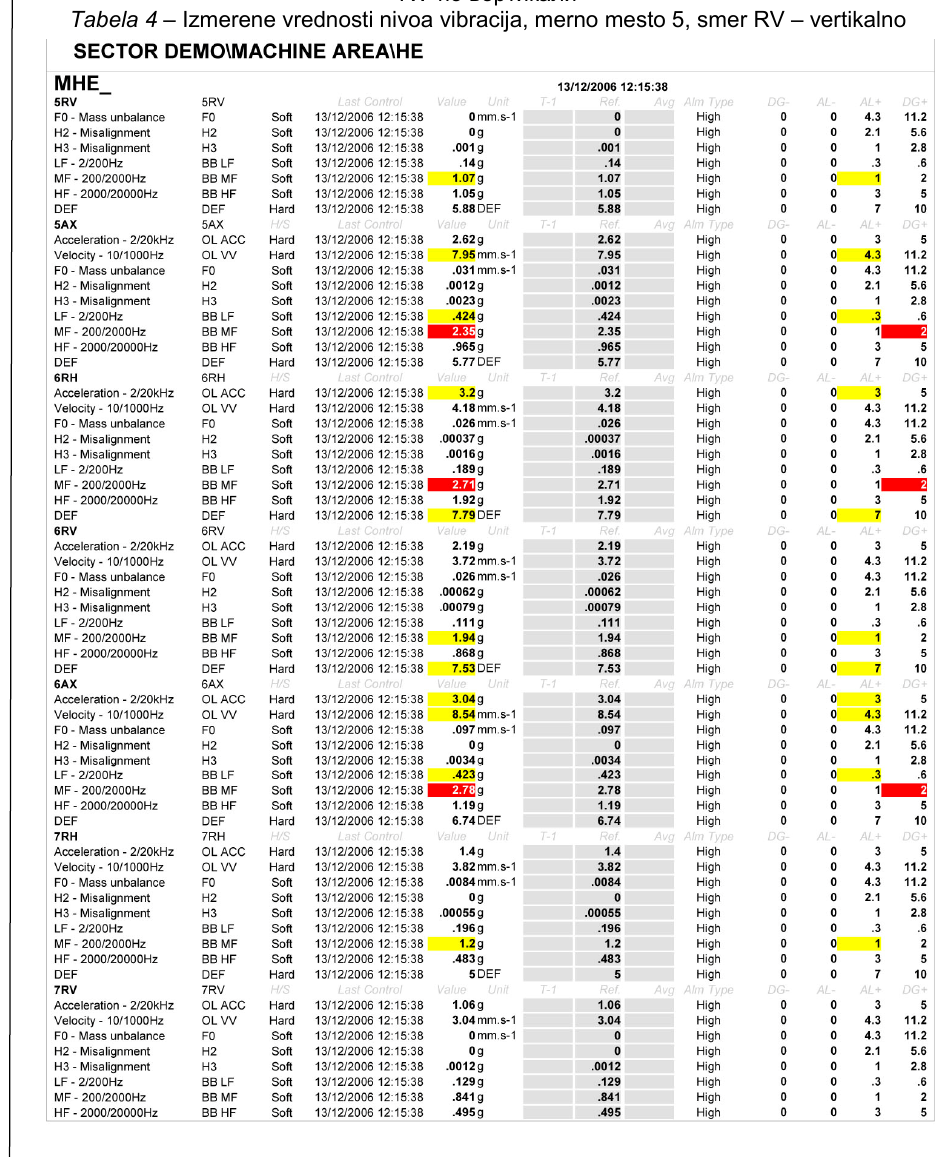
Table 4 – The measured values of vibration levels, measuring point 5, vertical direction-RV Таблица 4 – Измеренные значения уровня шума , контрольная точка 5,